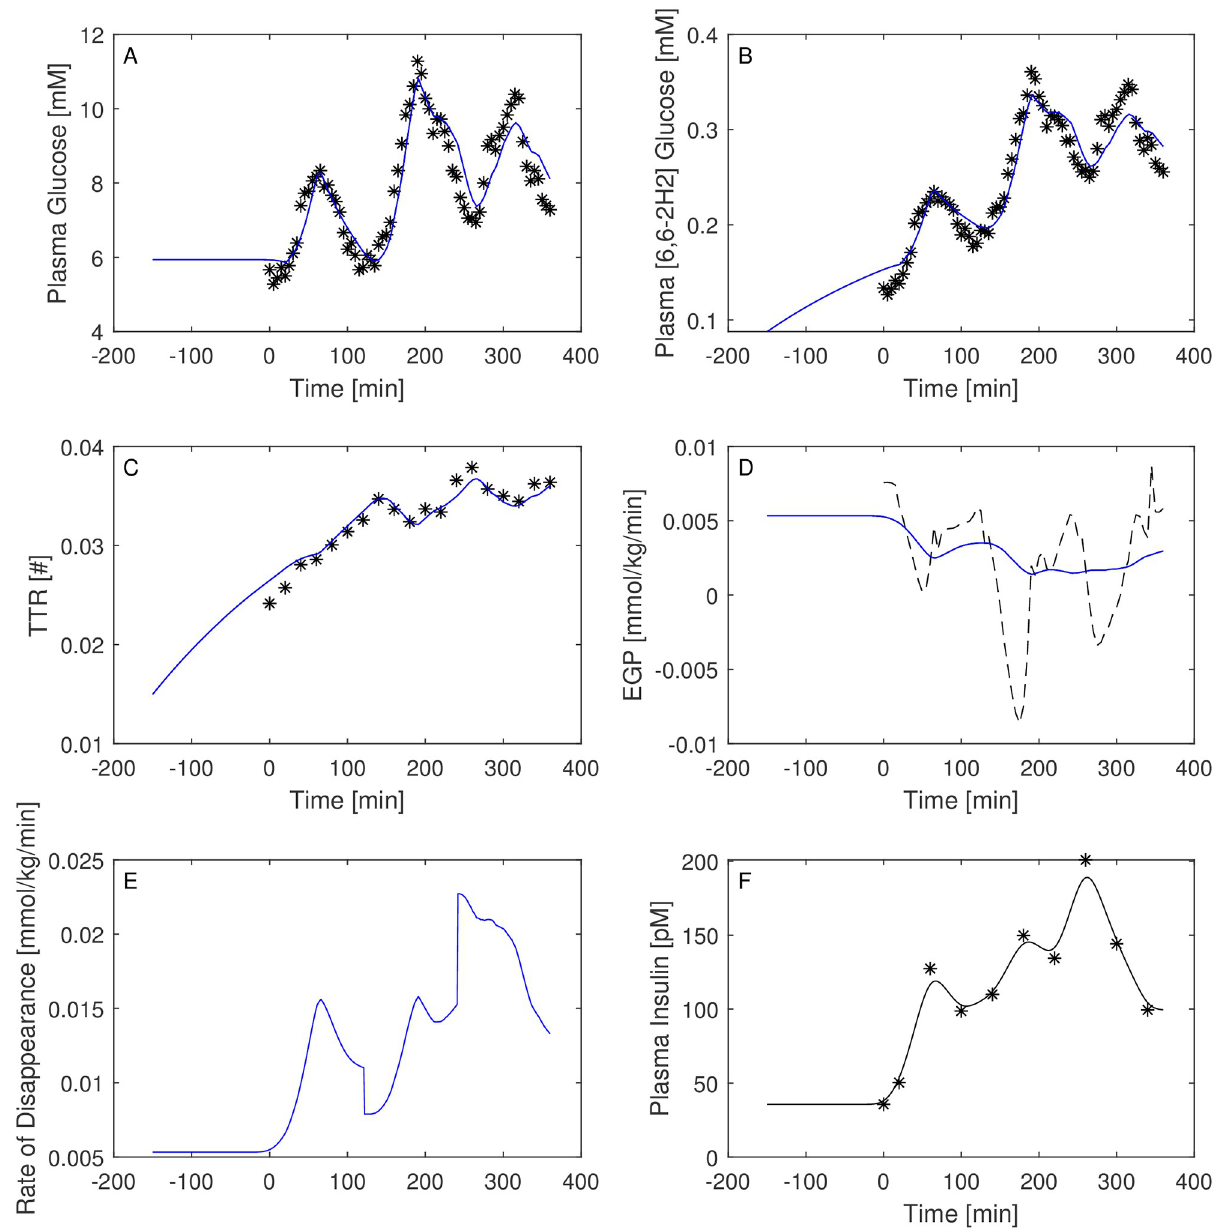
Fig 3. Predictions for Subject 1. Observed (asterisks) and predicted (line) variables over time (NGT subject). EGP: Endogenous Glucose Production; TTR: Tracer to Tracee ratio. Plasma glucose concentration (Panel A); Plasma [6, 6-2H2]glucose (Panel B); TTR (Panel C); EGP (Panel D), dashed line is the predicted EGP with the Steele model; Rate of disappearance (panel E); Plasma Insulin concentrations (Panel F). All the observed points refer to data measured on day 2. Plasma glucose concentrations (panel A) are derived from the glucose intra-venous infusion to match plasma glucose observations from the OGTTs of day 1. Black lines in panels A, B, C, D and E are model predictions from WLS estimation procedure; blue lines derive from the estimation approach which uses autocorrelated errors. performed by using smoothed interpolated TTR data, as well as smoothed Ra and EGP data, with distribution volumes equal to 145 ml and 40 ml, respectively; the continuous black line represents the predicted EGP estimated with the proposed modelling approach. Figs 3–8 report the observations and the predictions of ‘total’ and ‘hot’ plasma glucose con- centrations, as well as of TTR, along with the model predicted EGP (continuous lines)